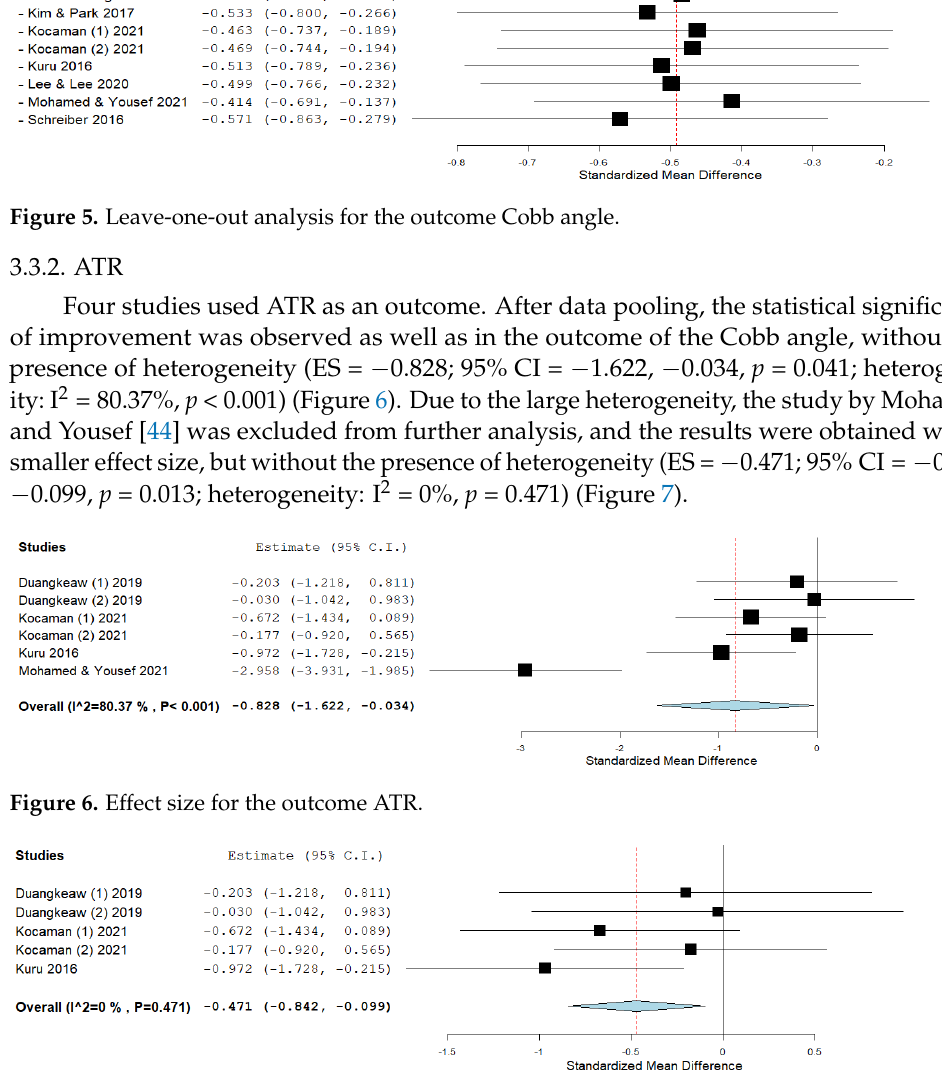
Figure 7. Effect size for the outcome ATR, without the study by Mohamed and Yousef [44].